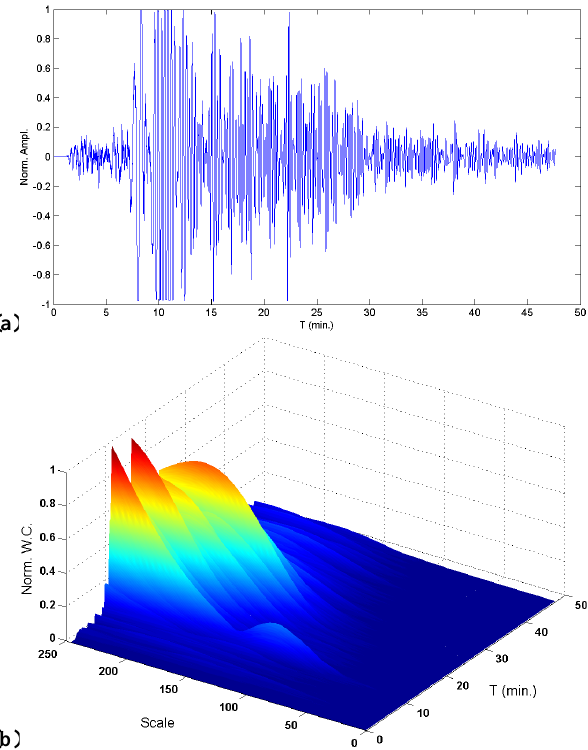
Fig. 2. Wavelet Analysis of Sumatra Earthquake (26